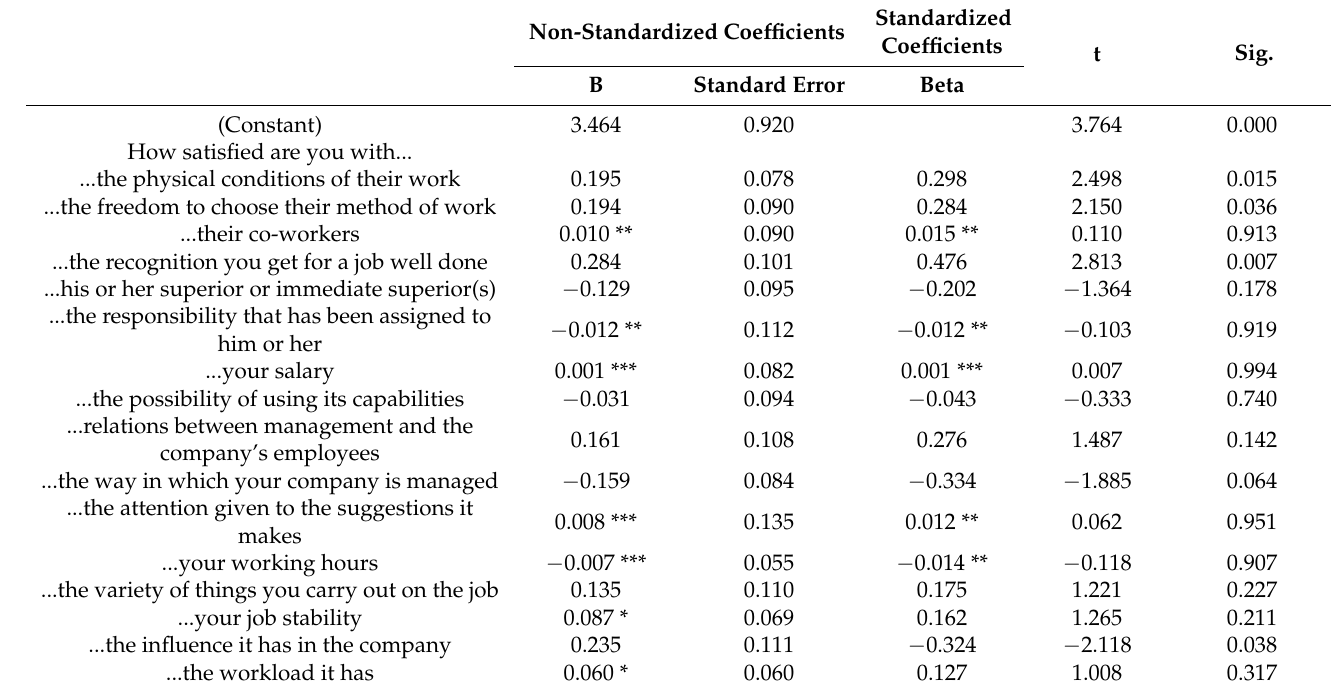
Table 7. Regression Coefficients Model 1 (Job Satisfaction Scale).